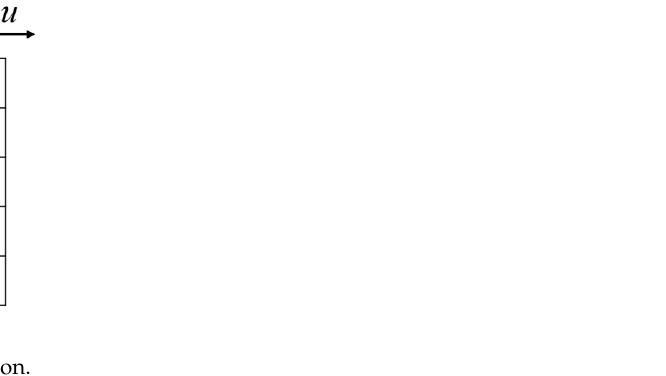
Figure 3. 4-path cost aggregation.